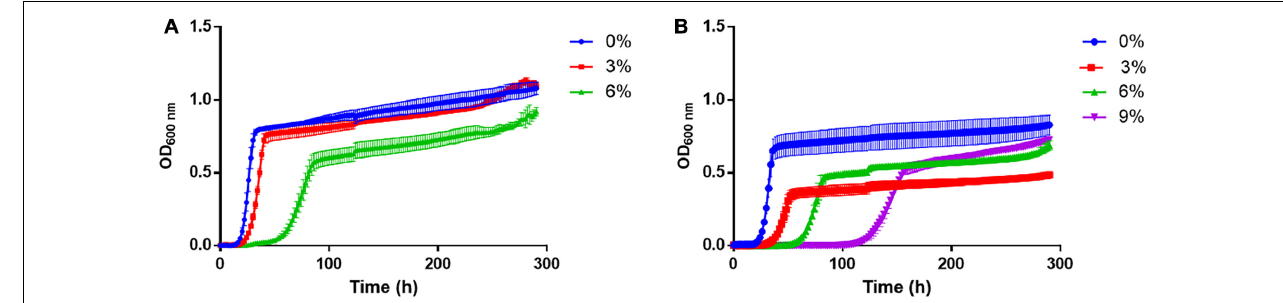
FIGURE 2 | Growth curves of (A) T. delbrueckii Biodiva TM and (B) YCPUC10 strains, exposed to different concentrations of ethanol.